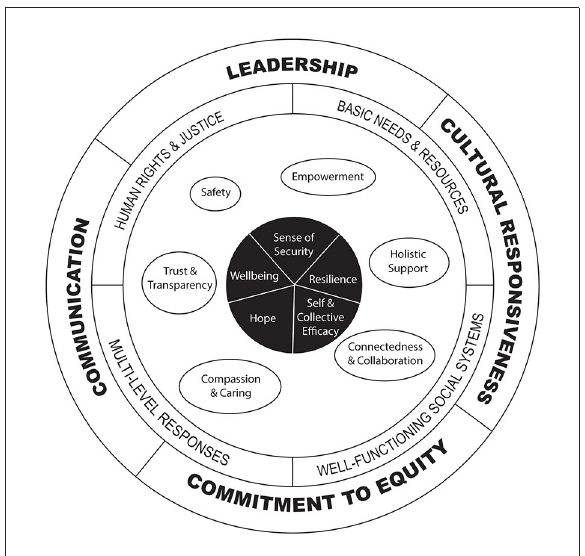
FIGURE3 Visual summary of core concepts